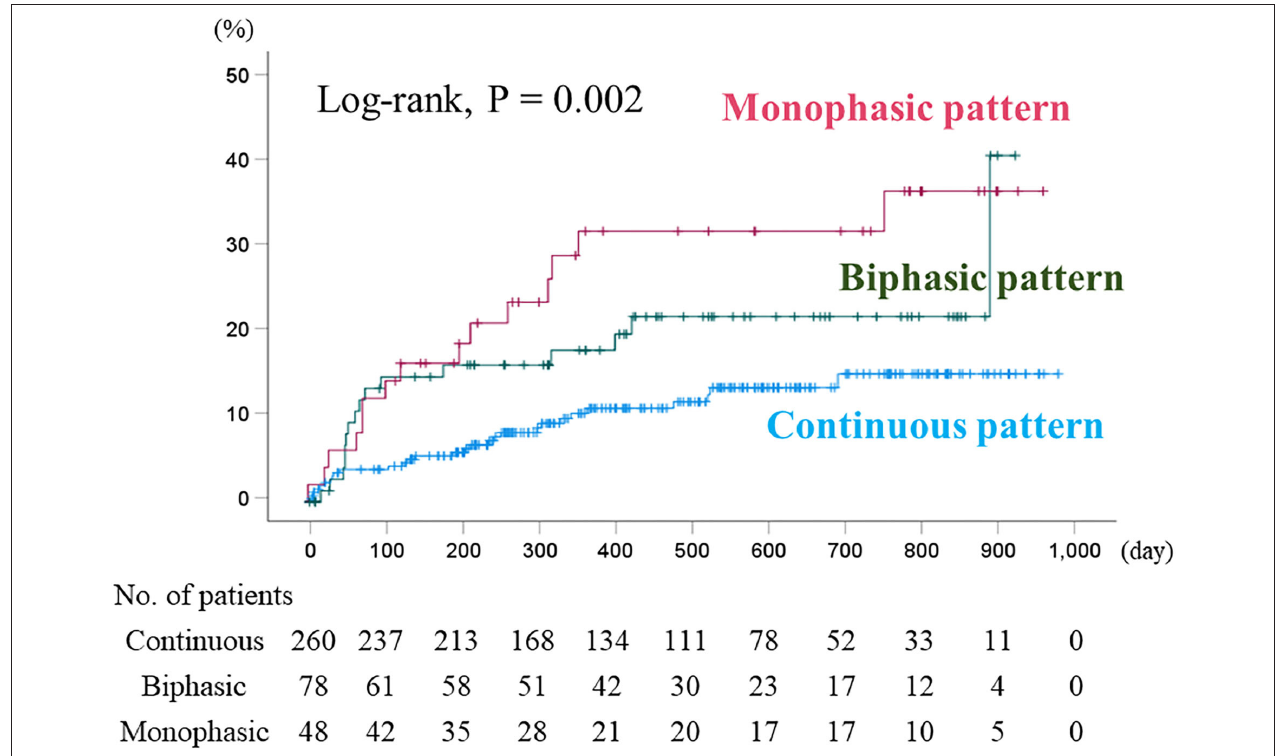
FIGURE 4 | Kaplan–Meier analysis for cardiac event rate stratified by IRVF patterns. The cumulative cardiac event rate significantly increased with worsening IRVF patterns (log-rank, P = 0.002). Although it showed basically similar to those of RVSI classification, there were overlap and inversion between the groups with biphasic and monophasic IRVF patterns. IRVF, intrarenal venous